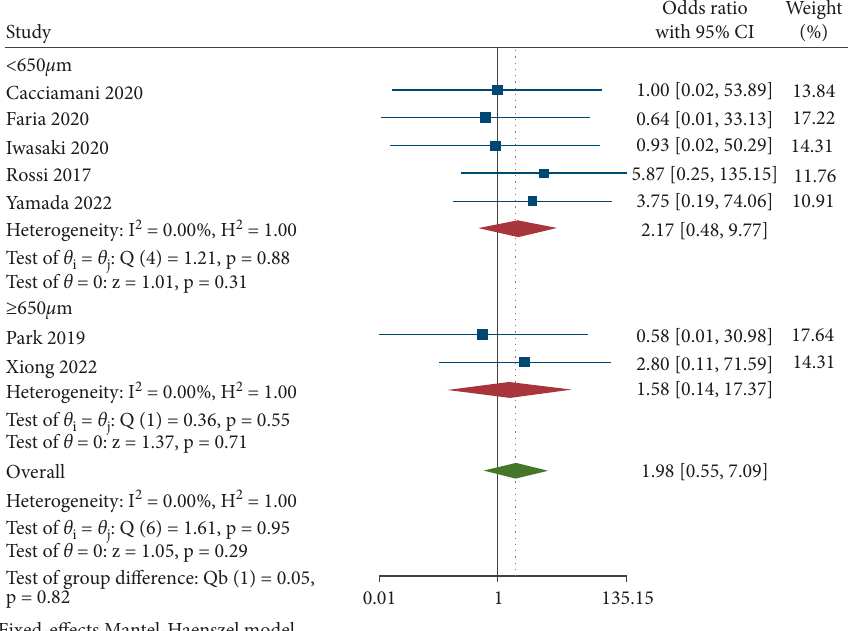
Figure 2: Forest plot of MH closure rate of ILM flap covering technique versus ILM flap filling technique.